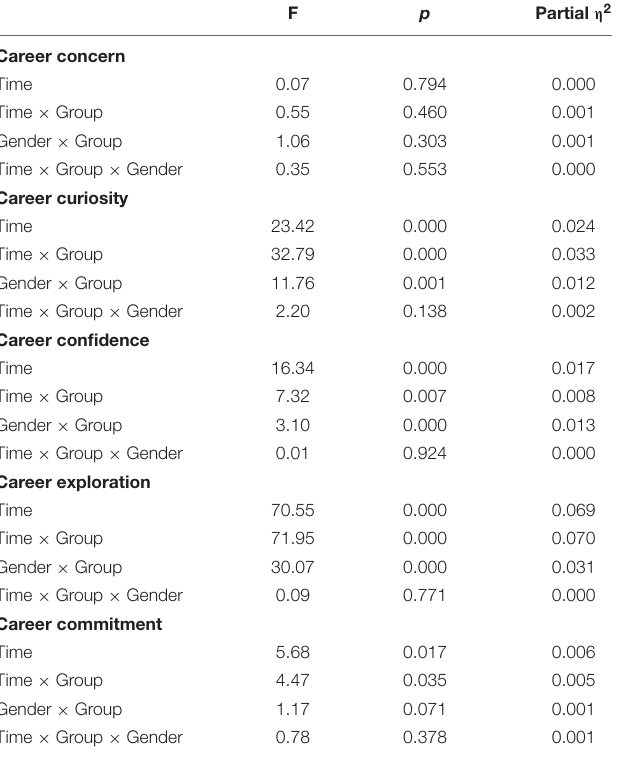
TABLE 3 | The effects of the intervention on career readiness and the moderating effect of gender. F p Partial η 2